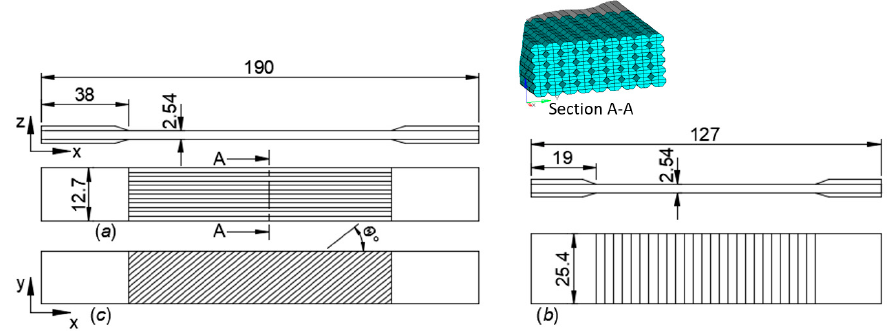
Figure 1. Dimensions of tensile specimens ( a ) fiber orientation along x -axis; ( b ) fiber orientation along y -axis, ( c ) fiber orientation 45° to x -axis.